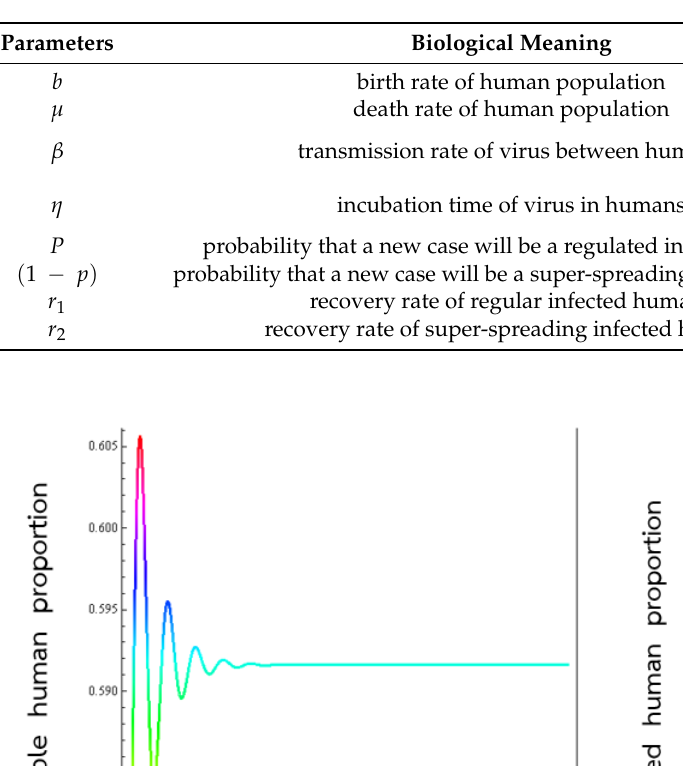
Table 1. Parameters used in simulation for this model.